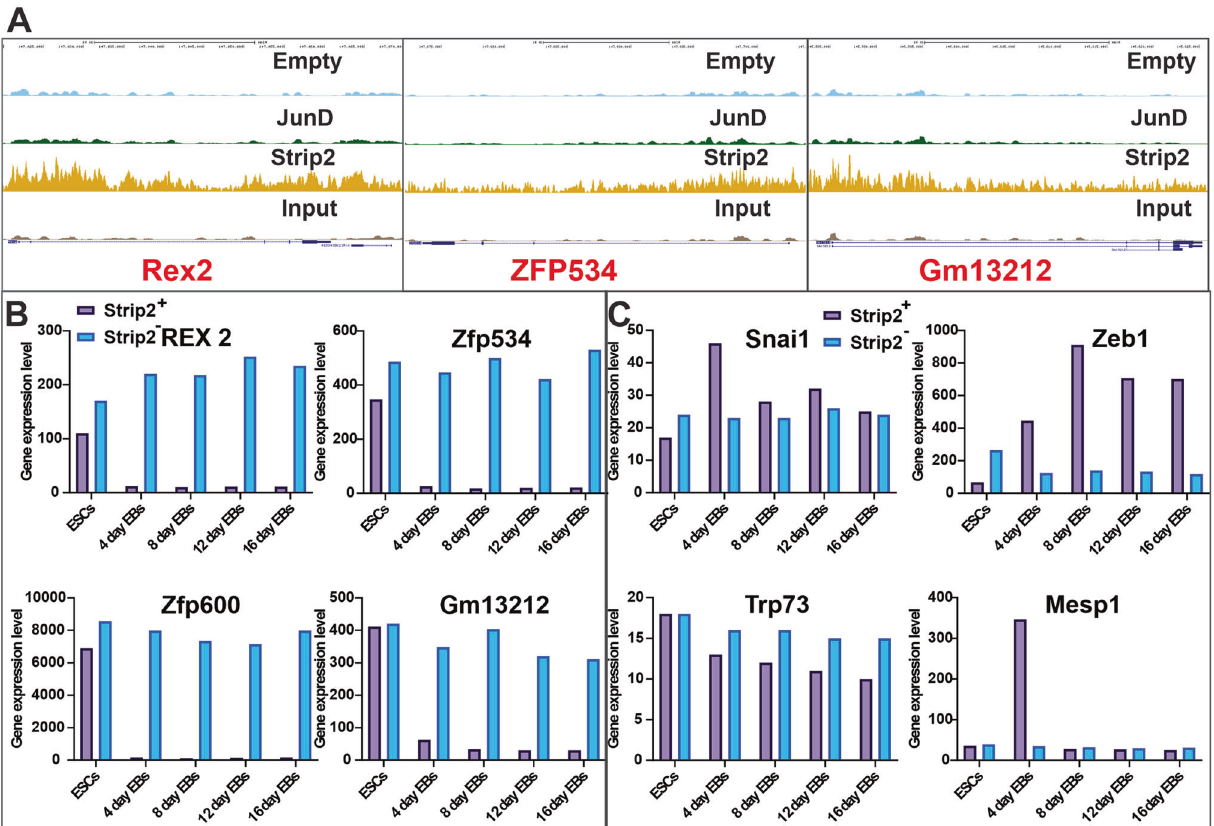
Fig. 3 Strip2 ChIP-Seq pro fi les of Rex2, Zfp534 and Gm13212 genes, their expression and the Strip2 motif targeted genes expression pattern during differentiation of mESCs. A Strip2 ChIP-Seq pro fi les generated in mouse ESCs of Rex2, ZFP534 and Gm13212 with control (empty vector and JunD). B Strip2 ChIP-enriched gene expression pattern in transcriptomic data of ESCs differentiation from day 0 to day 16. C Motif targeted gene expression pattern in transcriptomic data of ESCs differentiation from day 0 to day 16. ChIP-Seq: Chromatin Immuno- Preciptiation Sequencing.